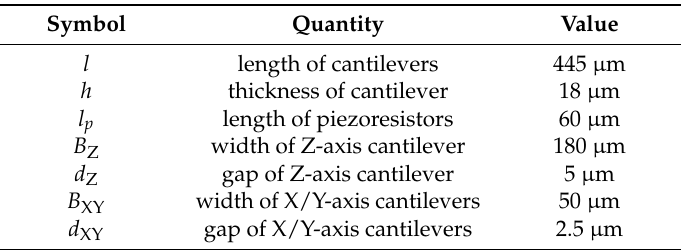
Table 1. Designed dimensions of the cantilevers.